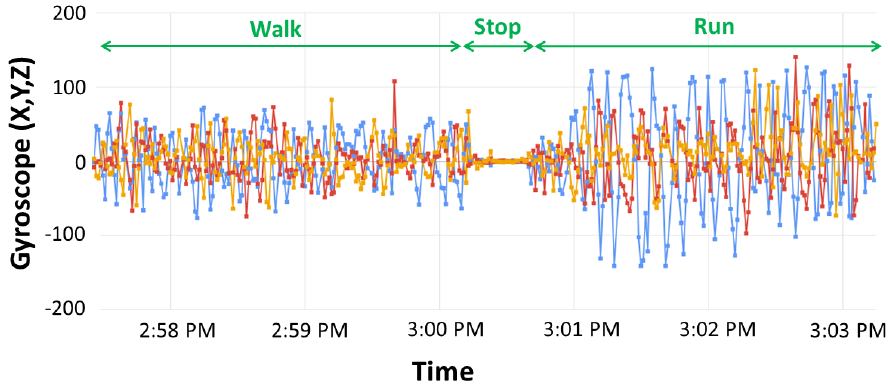
Figure 9. Gyroscope records over 5 min during the experiment. The X-axis is real time.